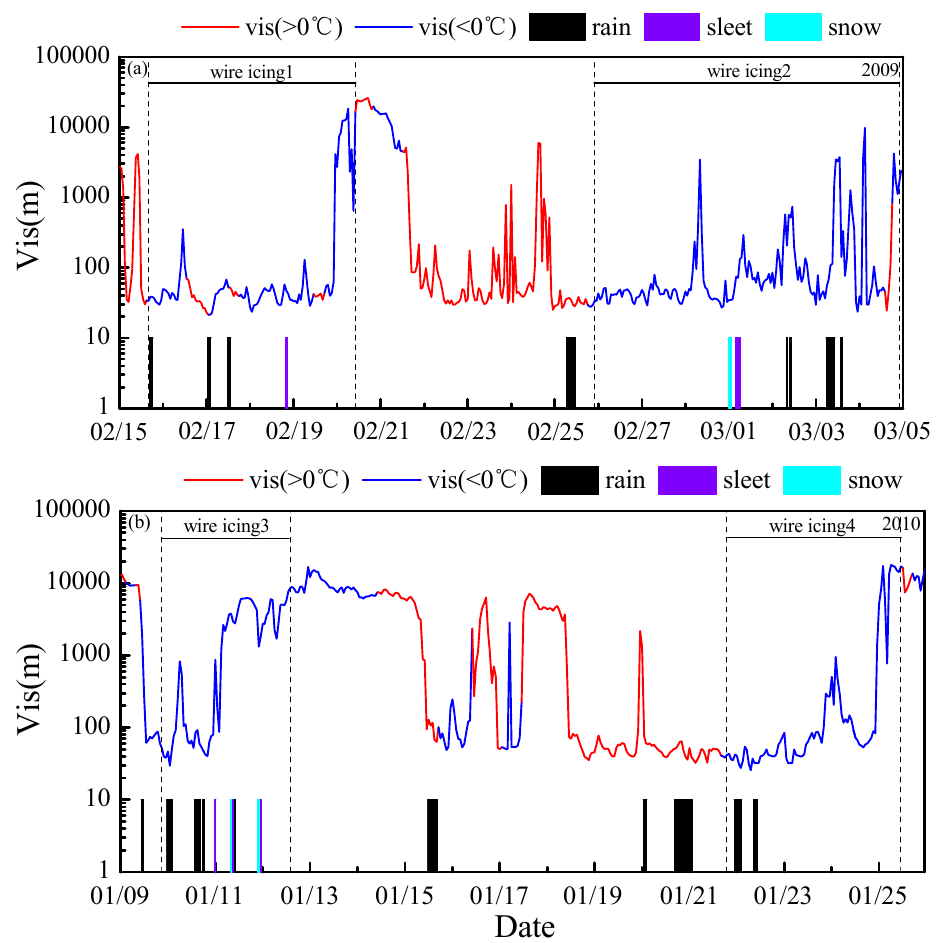
Figure 2. Temporal evolution of visibility, temperature, and occurrence time of rain, sleet, and snow in two winter observations in ( a ) 2009; and ( b ) 2010.